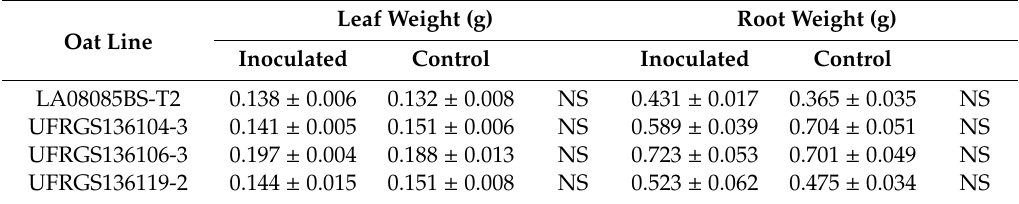
Table 3. Fresh leaf and root weight of oat lines at 40 days postinoculation (dpi) with M. graminicola .